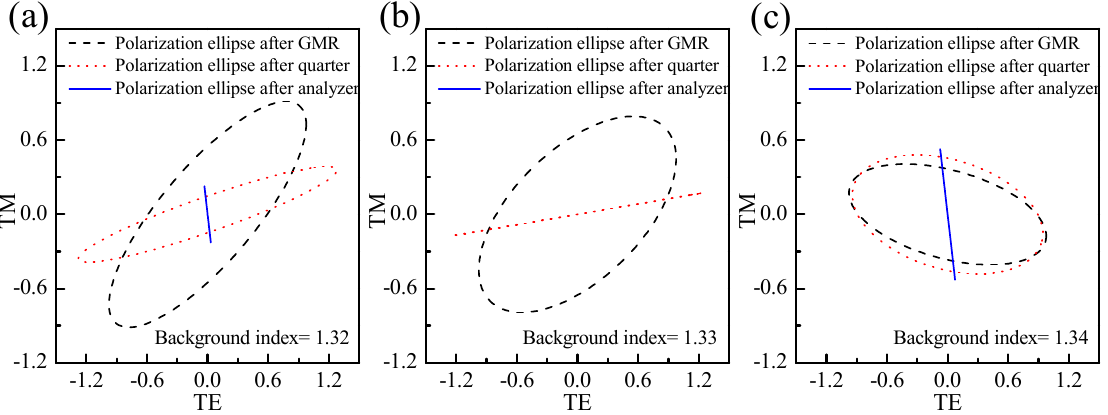
Figure 3. Polarization ellipses for background indexes equal to ( a ) 1.32; ( b ) 1.33; and ( c ) 1.34. The ellipse is calculated from Figure 2a; the orientations of the quarter and analyzer plates are to 34.84° and 97.97°, in order to specifically suppress the transmission intensity for